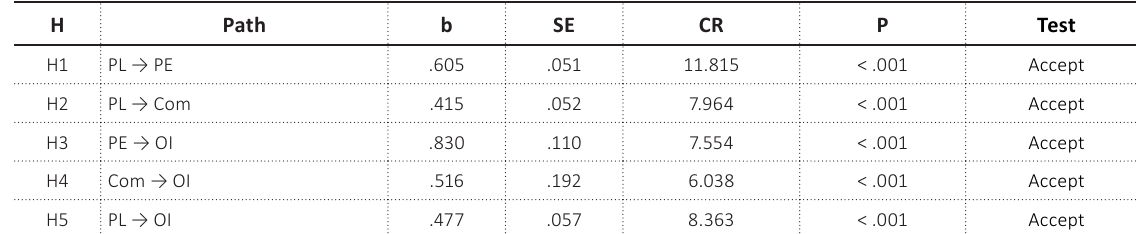
Table 3. Path analysis results